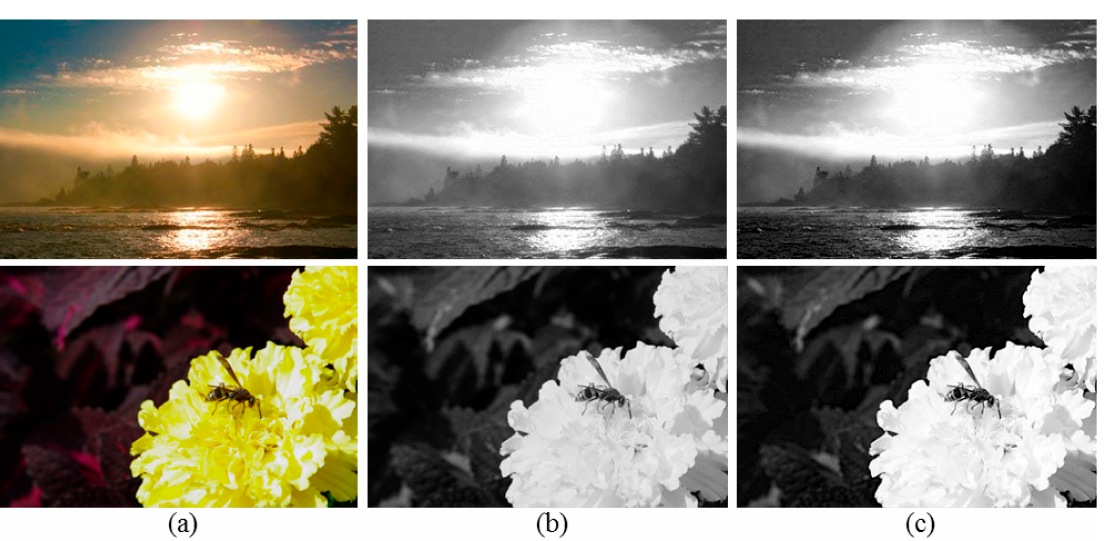
Figure 4. Perceived brightness estimation results. ( a ) Original images; ( b ) The V images of (a); ( c ) The perceived V images of